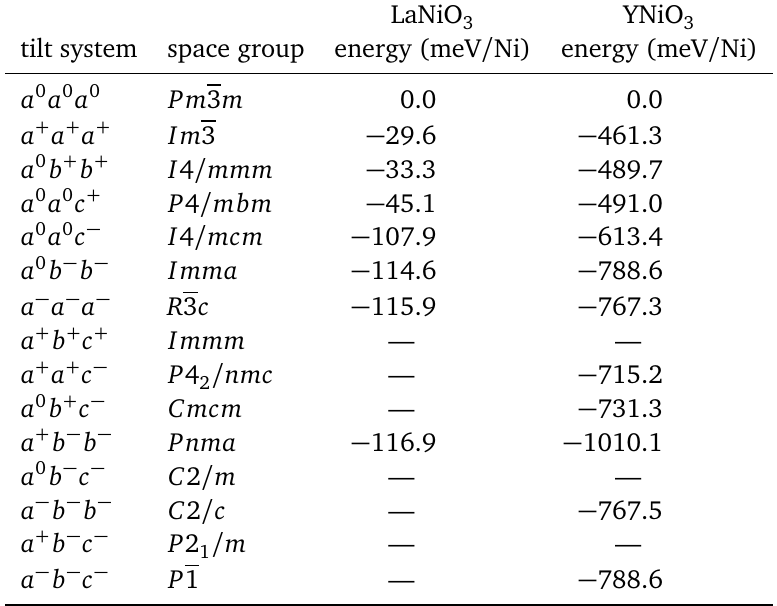
Table 1: The relative total energies of LaNiO The energies of the Glazer tilts that could not be stabilized are denoted by